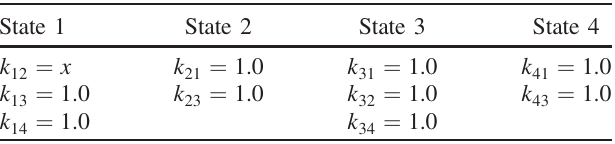
V. Transition rates for the counterexample. The net- work is given by Fig. 4 with the specified configuration of